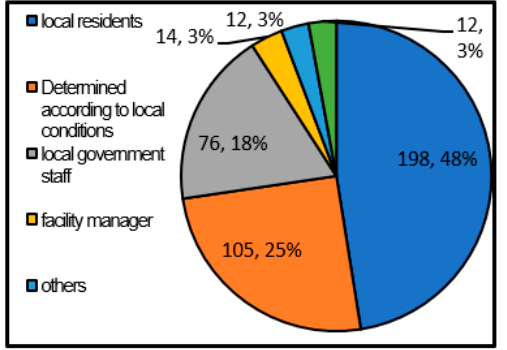
Figure 11. Shelter operation manager (single answer) (Single answer, total number of answers 417, total number of local governments: 417, unit: group).